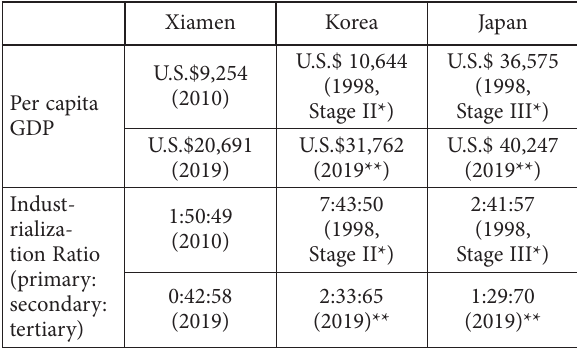
Table 1. Comparison of economy indicators in different stages